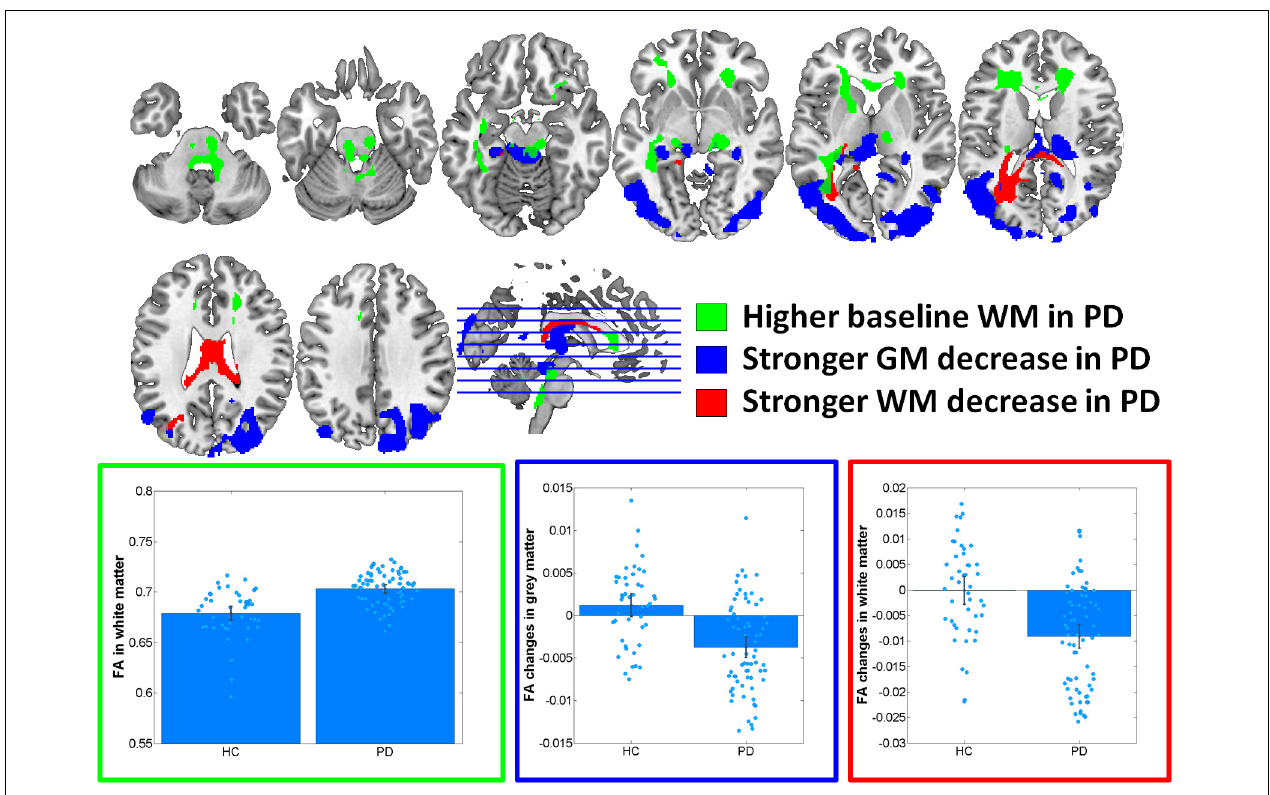
FIGURE 1 | Results of voxel-based morphometry analyses of fractional anisotropy (FA) maps. Bar plots show the eigenvariates extracted from the displayed significant clusters. Outline colors of the bar plots correspond to the contrast colors of respective clusters. HC, healthy control participant; PD, Parkinson’s disease patients; GM, gray matter; WM, white matter.